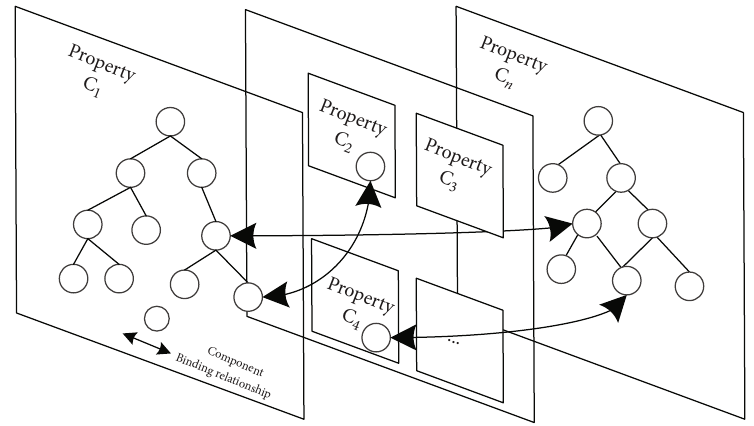
Figure 1: The relationship between properties and